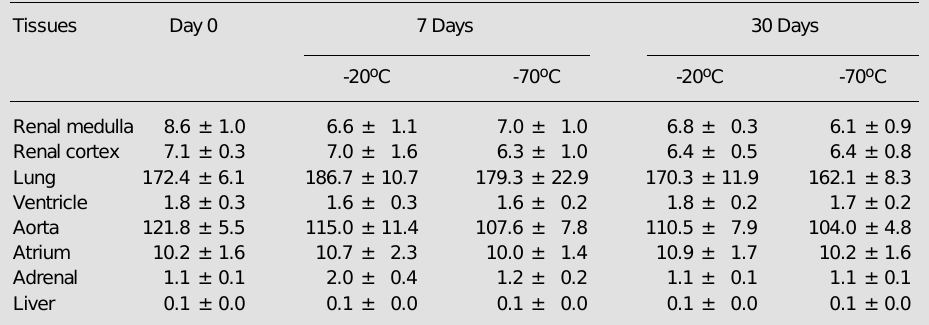
Table 4 - Stability of ACE activity in tissue homogenates stored at -20 o or -70 o C for 7 or 30 days. Analysis was performed on fresh and stored tissue homogenates. The enzyme activity was assayed as described in Material and Methods. Results are expressed as nmol His-Leu min -1 mg protein -1 . Data represent the mean ± SD of three independent